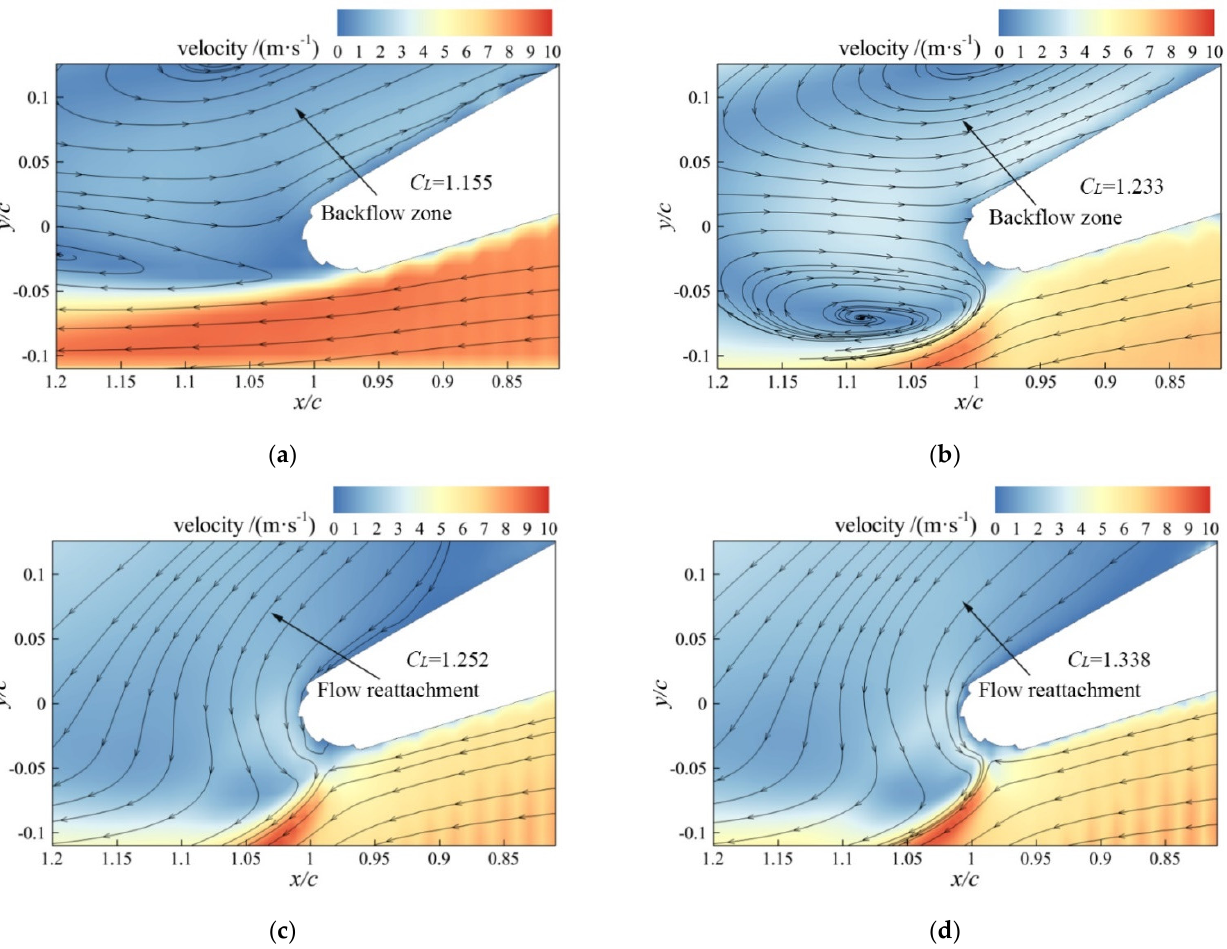
Figure 12. Comparison of velocity cloud and streamline diagrams with different number of slots ( U ∞ = 8 m/s, AOA = 20°). ( a ) No slot. ( b ) Single slot. ( c ) Two slots. ( d ) Three slots.